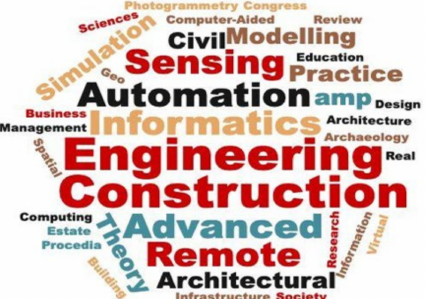
Figure 2. Word cloud from the 4 databases obtained using the search term “Scan to